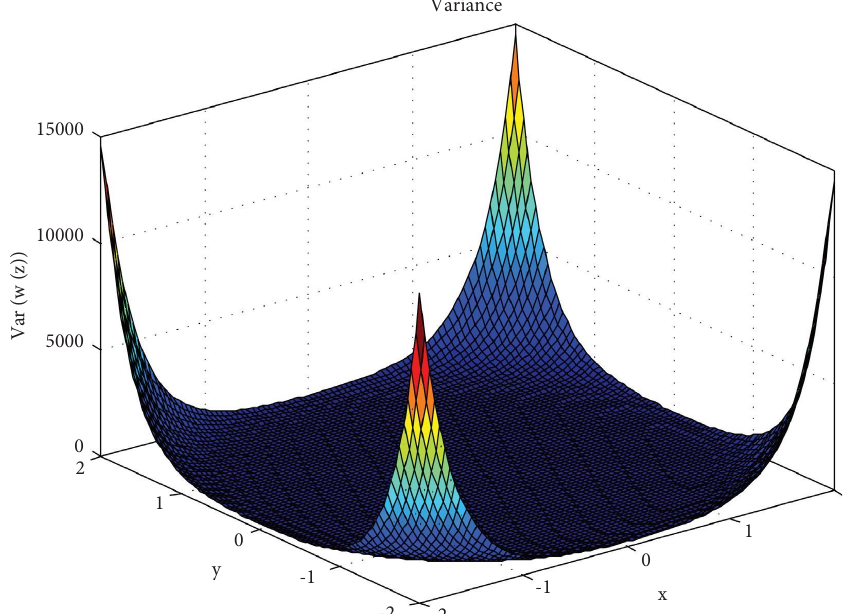
Figure 8: Variance of equation (38) for α � 1, β �